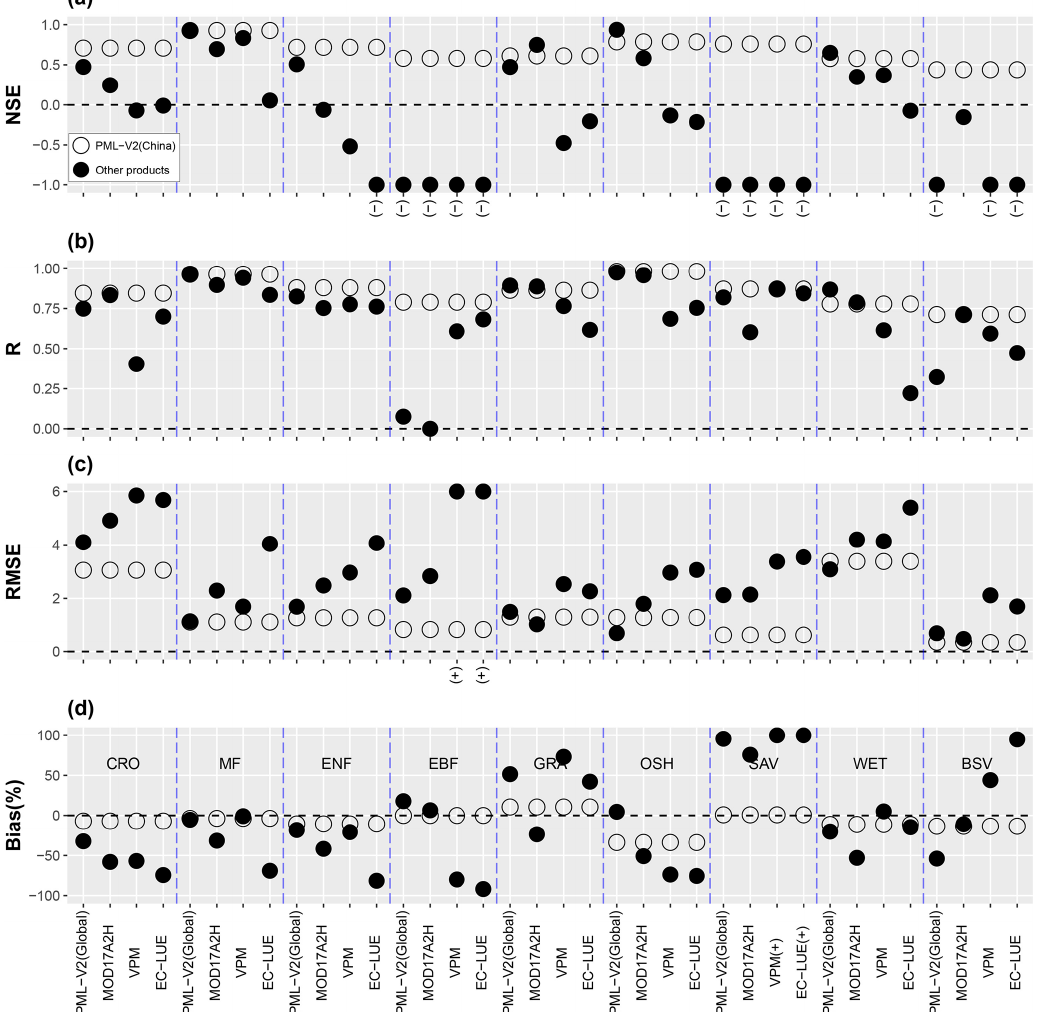
Figure 8. Statistical indicators of PML-V2(China) and other models for estimating GPP at each PFT. Open and solid dots represent PML- V2(China)-estimated GPP in cross-validation mode and other models. PML-V2(China) is upscaled to 8d to compare with the 8d resolution of PML-V2(Global), MOD17A2H, EC-LUE, and VPM. Note that “( + )” indicates that the model’s simulation statistics dot is more than